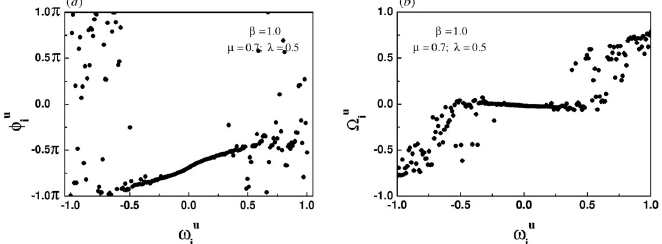
Fig 2. Snapshots of the instantaneous phases (left panel) and the effective frequencies (right panel) for the linear correlation when the intra-layer and inter-layer coupling strength are set to 0.7 and 0.5, respectively.